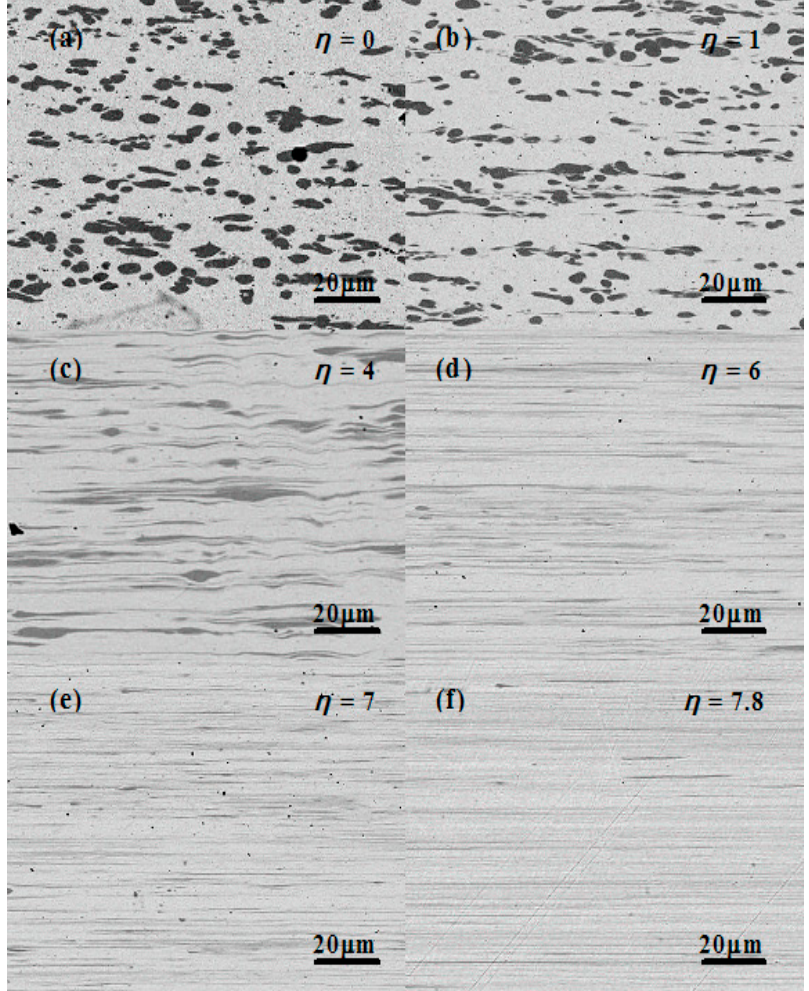
Figure 1. Cu–14Fe SEM microstructures at various strains: ( a ) η = 0; ( b ) η = 1; ( c ) η = 4; ( d ) η = 6; ( e ) η = 7; ( f ) η =